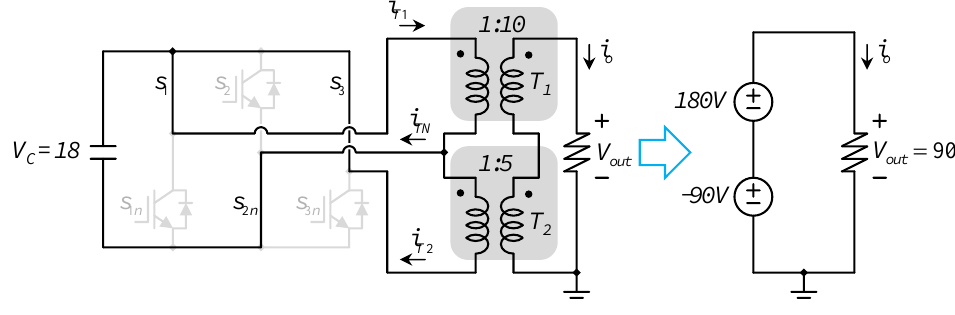
Figure 14. Equivalent circuit when s 1 = 1, s 2 = 0, and s 3 = 1 ( s 1 n = 0, s 2 n = 1, and s 3 n = 0).